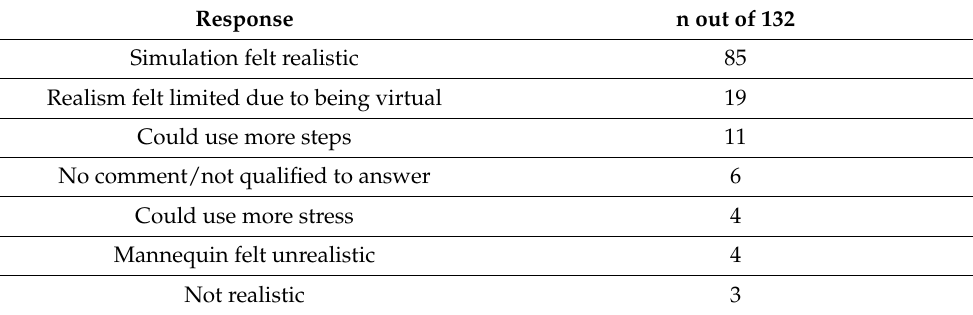
Table 8. Did the simulation feel realistic to